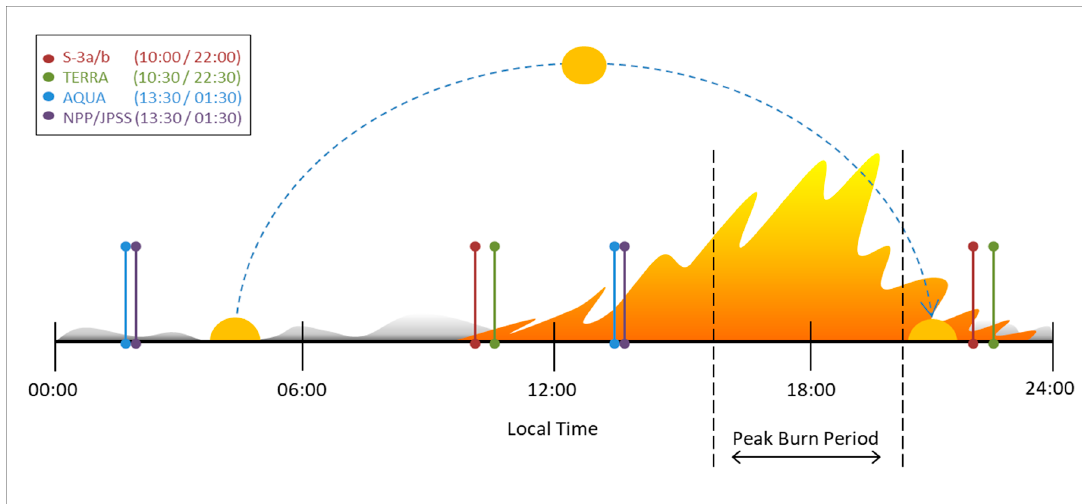
Figure 1. Active-fire satellite overpass time in relation to the diurnal wildfire activity cycle. Wildfire activity varies throughout the day in relation to the changing solar elevation and resulting changes in atmospheric moisture, ambient temperatures, and wind speeds. In general, wildfire activity is dominated by smoldering combustion overnight and in the early morning, and peaks in the late afternoon period centered around 18:00 local time known as the “peak burn period”. Notably, currently available active-fire low-earth-orbiting satellite observations from instruments such as SLSTR (Sentinel-3a/b), MODIS (TERRA/AQUA), and VIIRS (NPP/JPSS) fail to observe wildfires during the most active portions of the day.